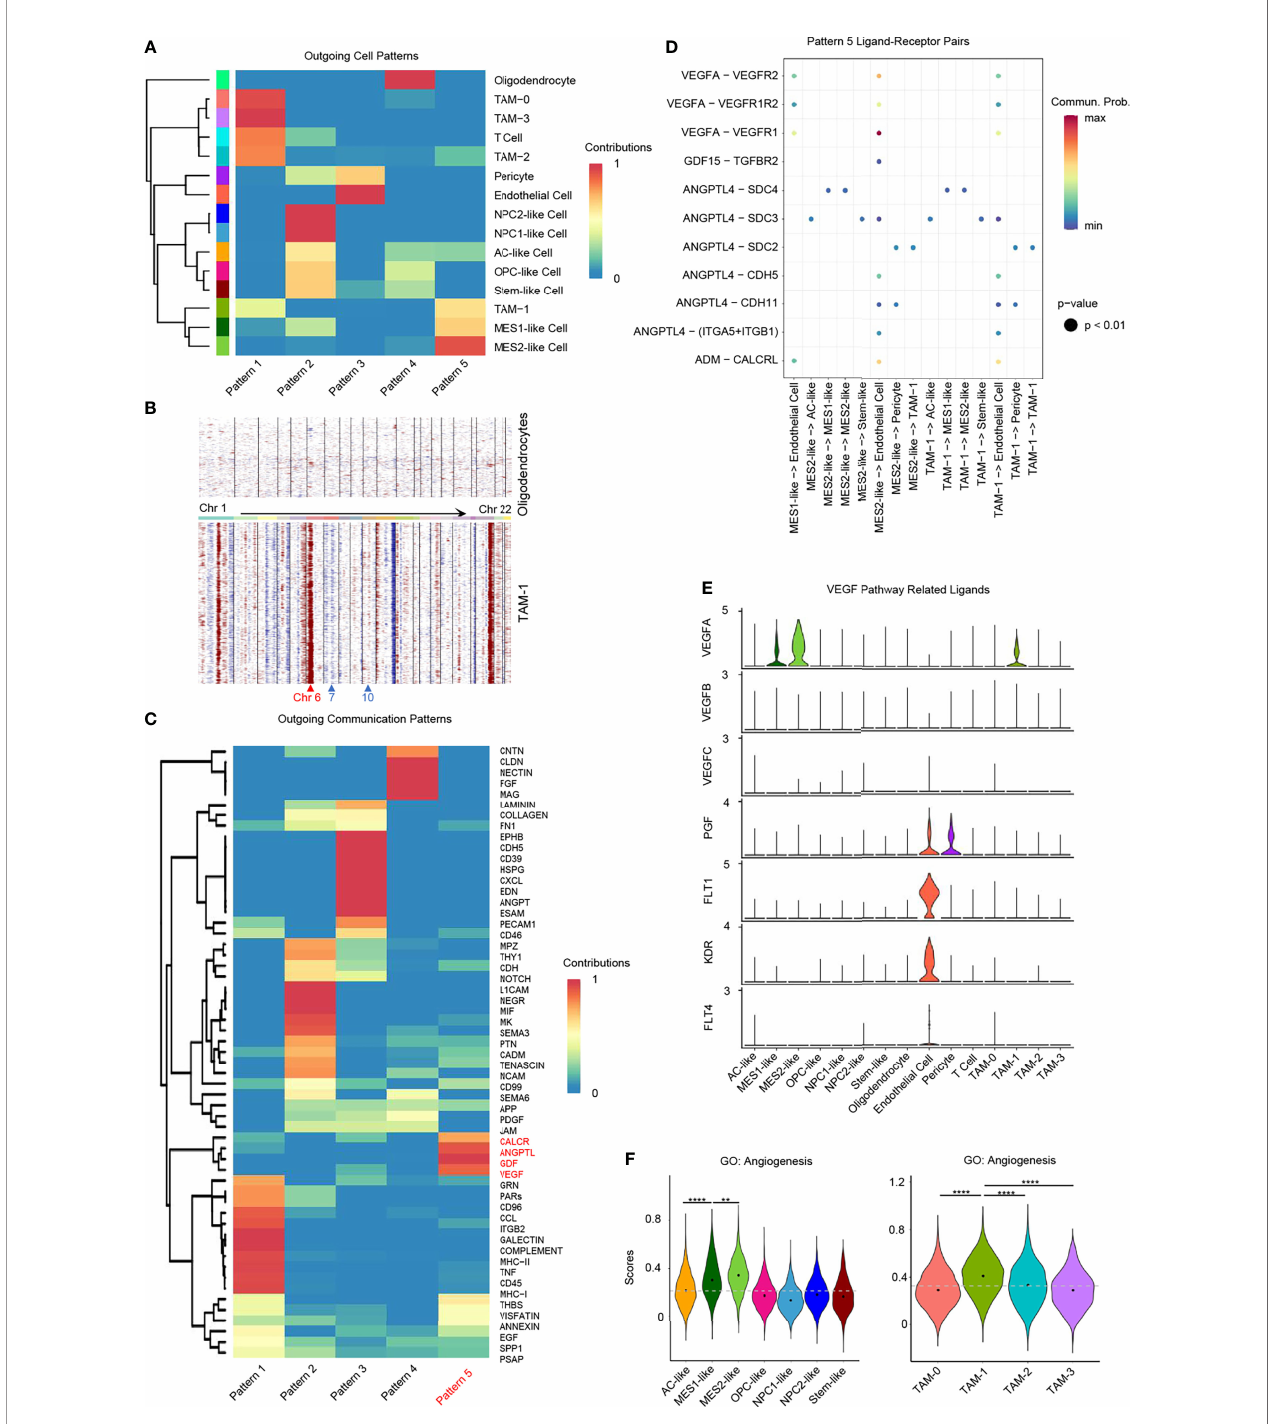
FIGURE 6 | Role of hypoxia-response cells in angiogenesis. (A) Cluster of GBM cell types according to the source cell functions in cell – cell communication. Hypoxia-response cell types, namely, MES1-like, MES2-like, and TAM-1 cells, were in the same pattern 5. (B) Compared to oligodendrocytes, TAM-1 cells presented with obvious CNVs in chromosome 6, but no CNVs in chromosomes 7 and 10. Red, ampli fi cation; blue, deletion. (C) Cell – cell communication-related pathways in different outgoing cell patterns. (D) Dot plot of outgoing cell pattern 5-related ligand – receptor pairs. (E) Violin plot of VEGF pathway-related ligand expression levels. (F) Violin plot of the angiogenesis gene set scores in GBM tumor cells and TAMs, respectively. Hypoxia-response cells, namely, MES1-like, MES2- like, and TAM-1 cells, had the highest score. Commun., communication; Prob., probability; gray dash line, average score; ** p < 0.01; **** p < 0.0001. See also Supplementary Figure 7